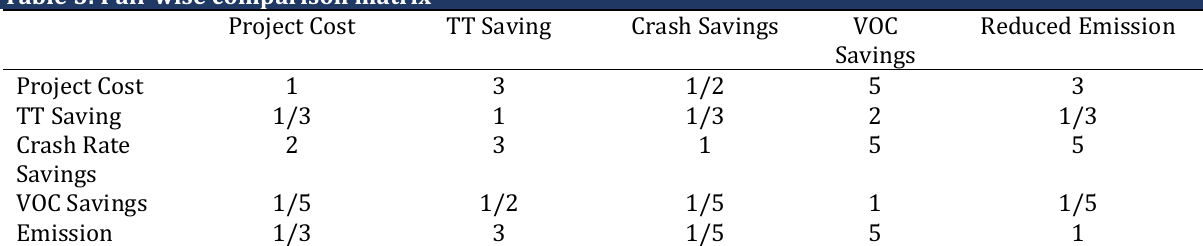
Table 5: Pair wise comparison matrix